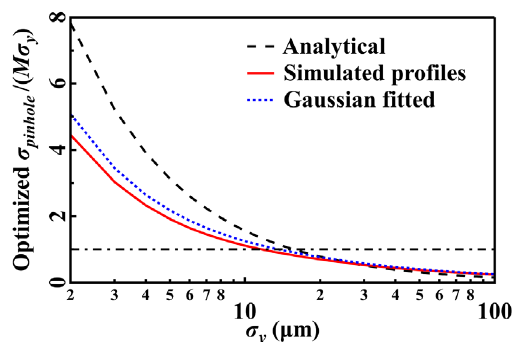
= ð M σ for different source sizes σ y Þ pinhole 1 = ð M σ y Þ ¼ pinhole